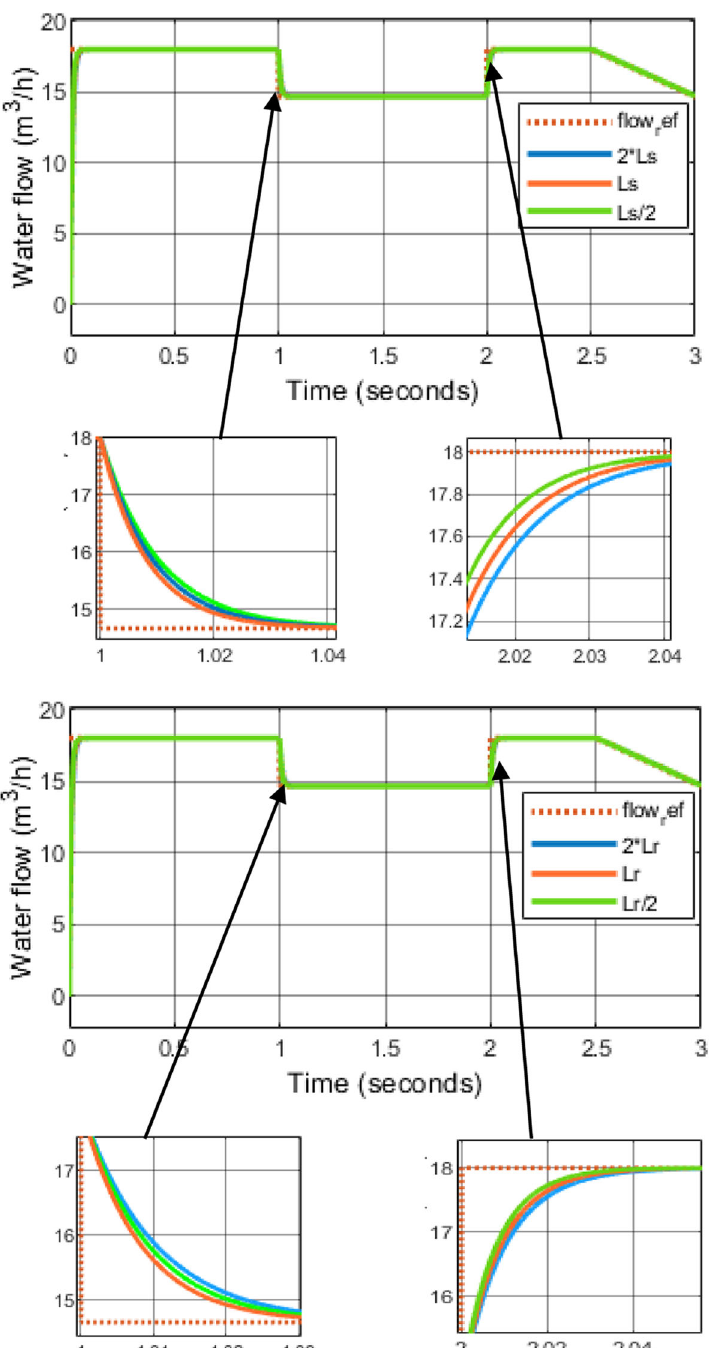
Fig. 22 Robustness test for a variation in the rotor and stator Fig. 19, in order to prove the robustness of the system against external disturbances.